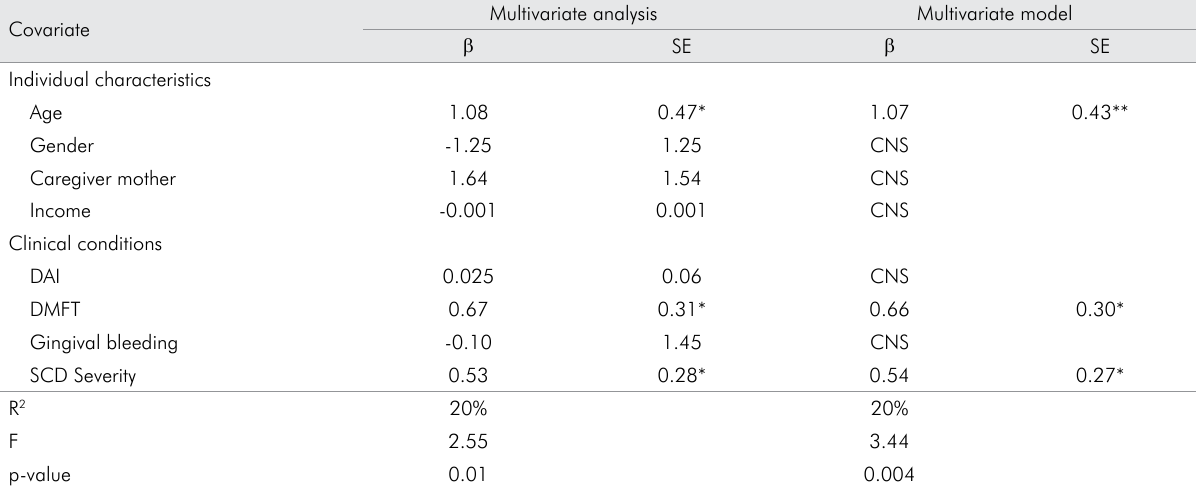
Table 4. Parent’s responses to the FIS (Family Impact Scale) in the survey (n = 106).